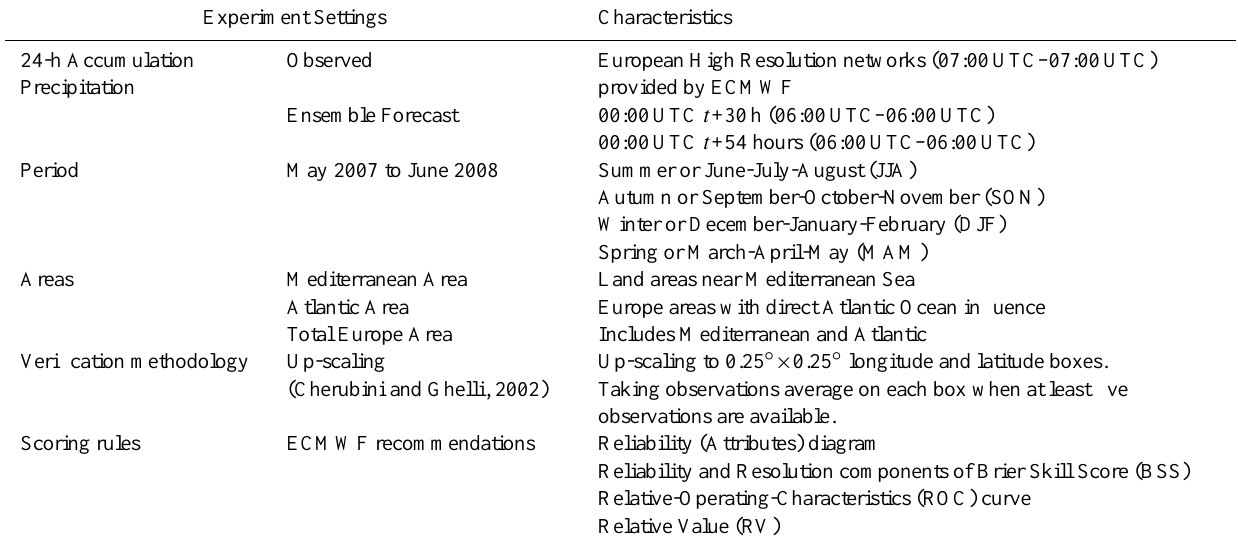
Table 1. Objective verification experiment settings and characteristics.